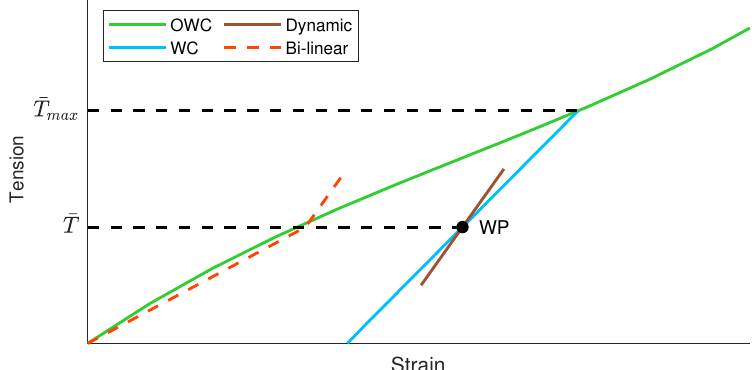
Figure 1. Illustration of the Syrope model (green, blue and brown lines) and bi-linear model (orange line) for a fibre rope under mean tension ¯ T . The historically highest mean tension is given by ¯ T max